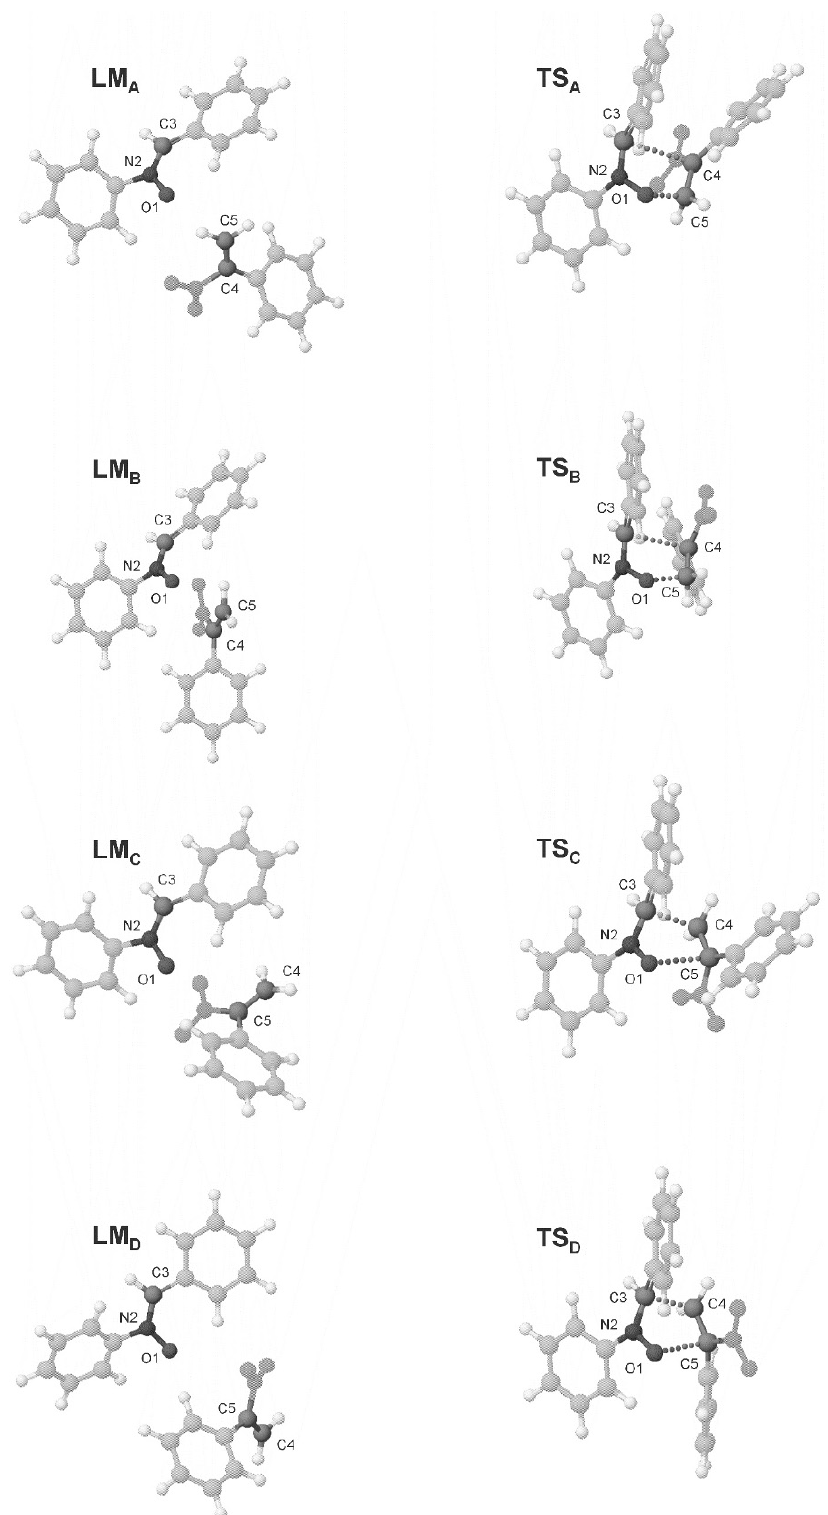
Figure 2. Critical structures for the [2+3] cycloaddition of a -phenylnitroethene 1 and (Z)-C,N-diphenylnitrone 2 in gas phase according to B3LYP/6-31G(d)